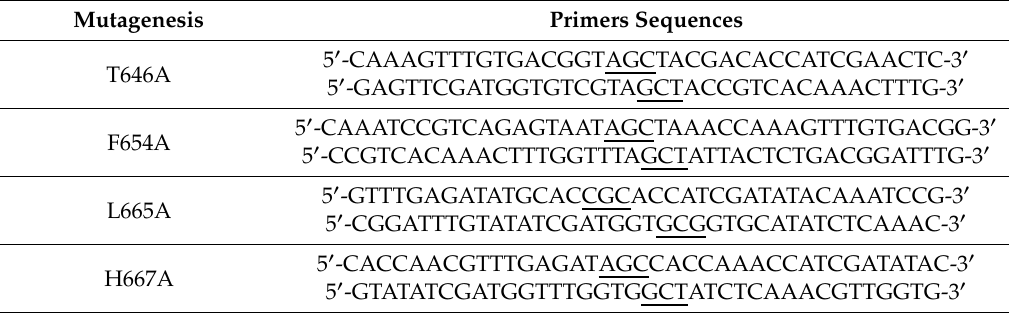
Table 5. Primers used for mutations of